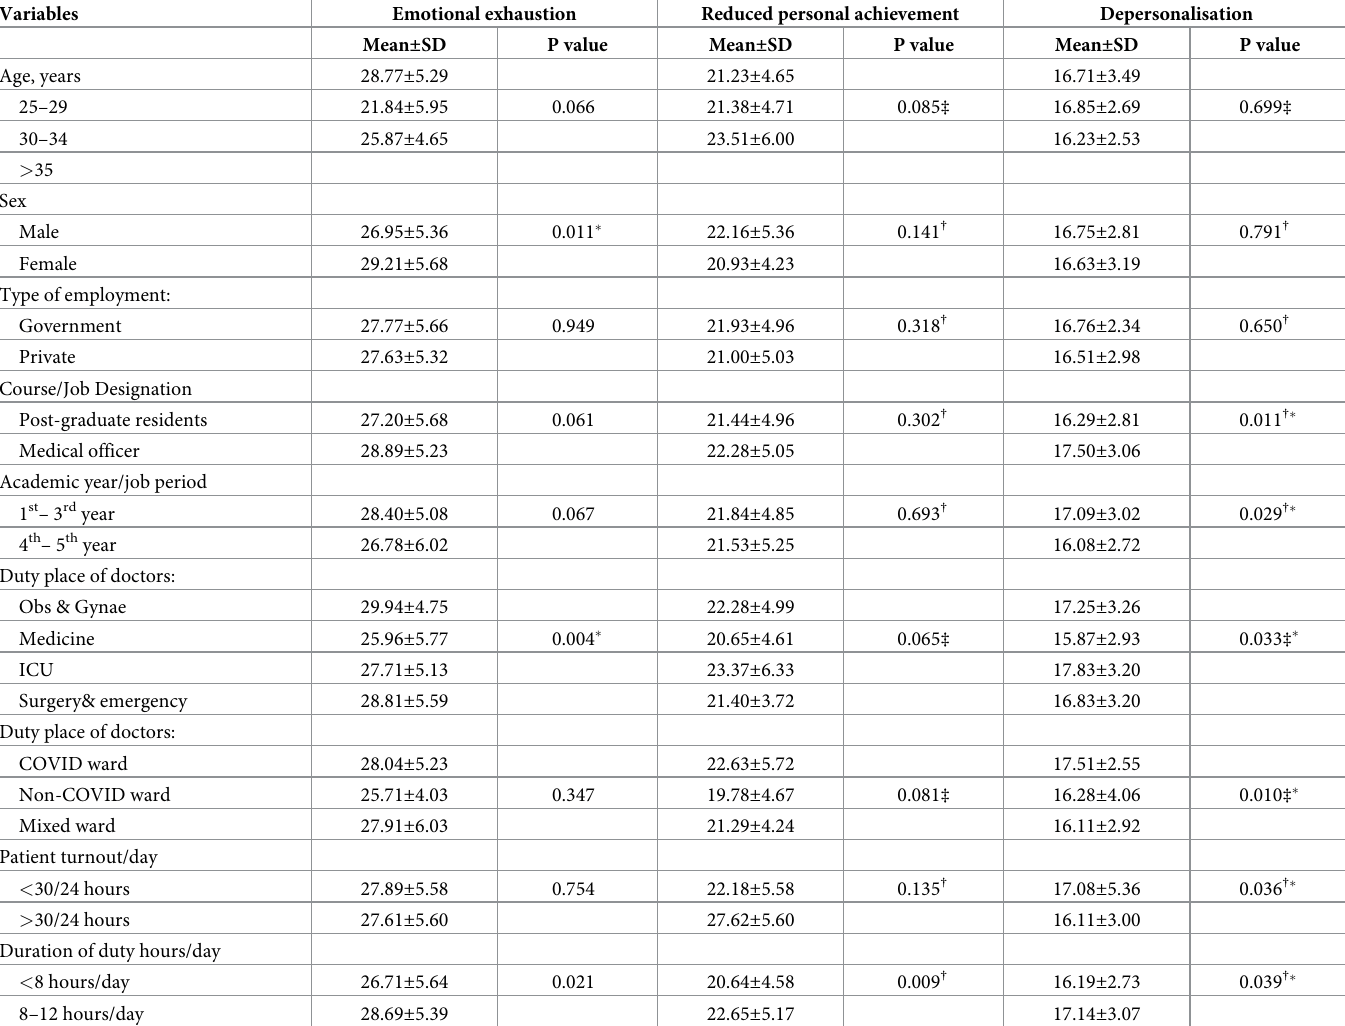
Table 4. Participants’ level of emotional exhaustion, depersonalisation, and reduced personal achievement by demographic and job-related characteristics (n = 168).